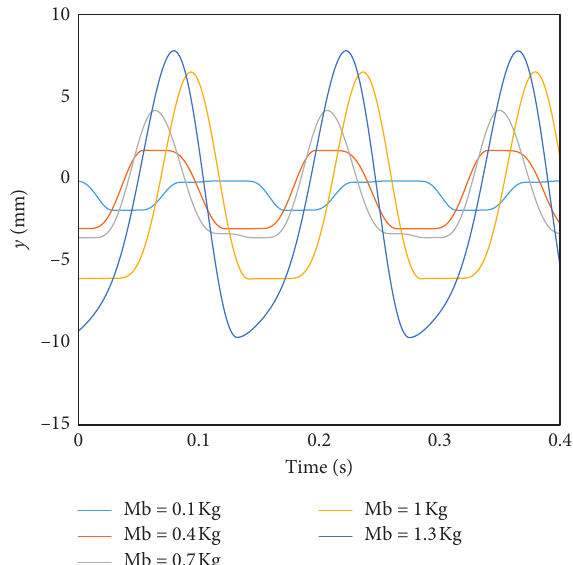
Figure 15: The influence of bolster mass on the response of the suspension system when excitation amplitude � 15 mm and frequency �